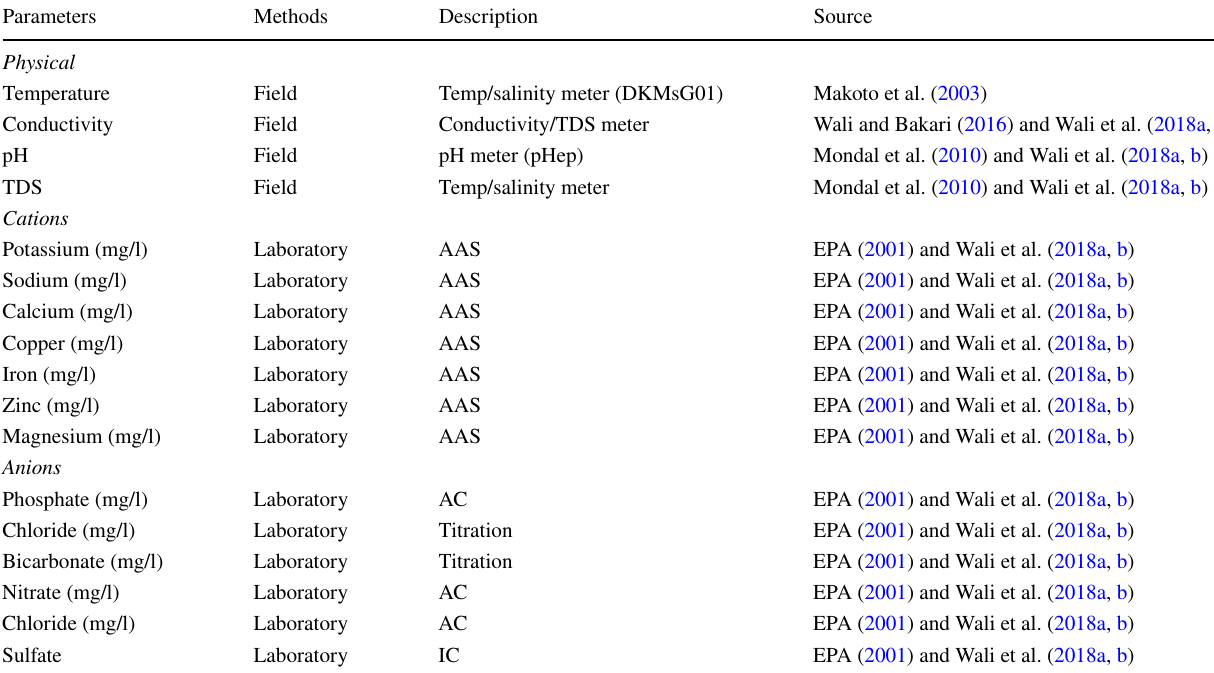
Table 1 Summary of field and laboratory